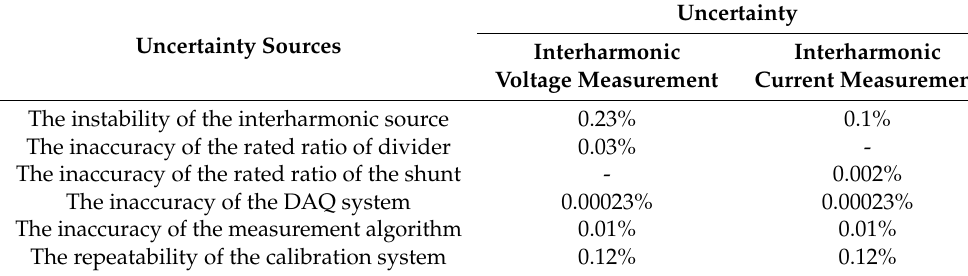
Table 1. Uncertainty sources and their calculated values. DAQ—data